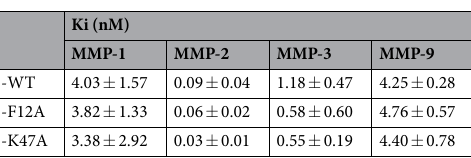
Table 1. Inhibition constants (Ki) of TIMP-1 mutants against MMP-1, MMP-2, MMP-3 and MMP-9. Mean values ± standard error are presented. Data are based on three independent